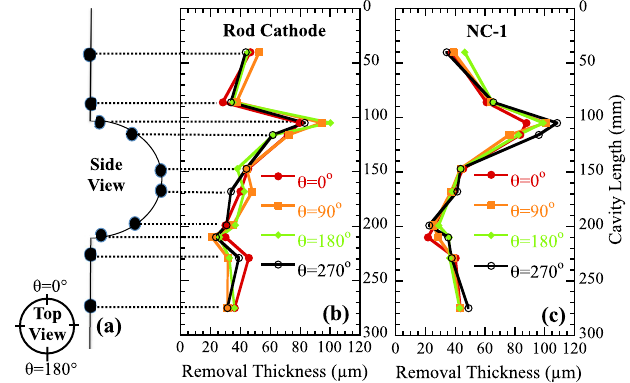
FIG. 7. (a) Black dots show positions of thickness measure- ments. Trends of the removal thicknesses in VEP performed with (b) rod cathode and (c)